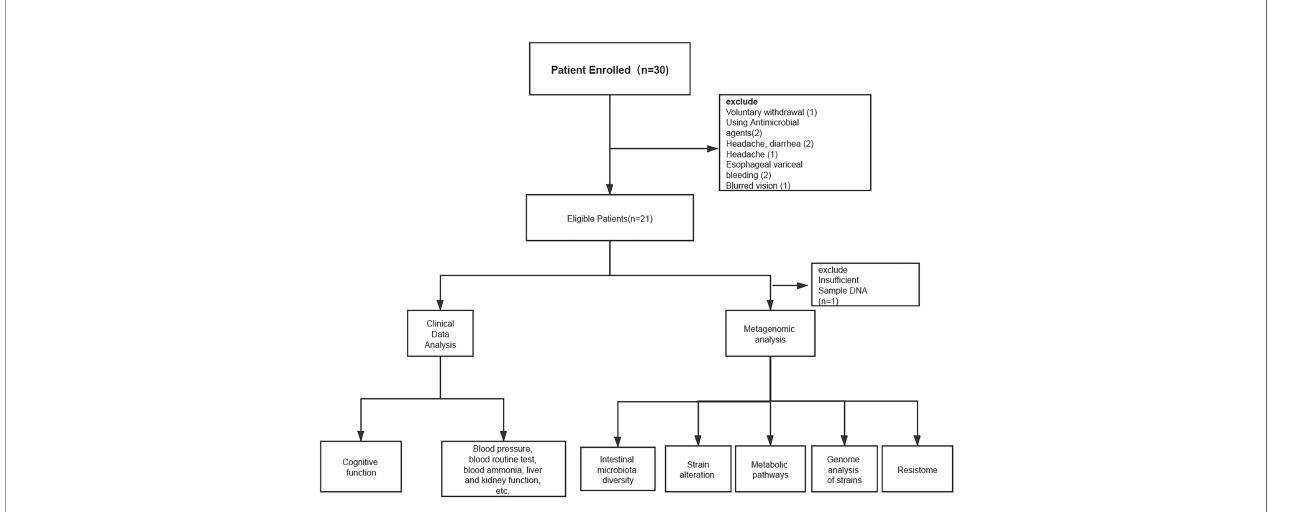
FIGURE 1 | Patient enrollment and research fl ow